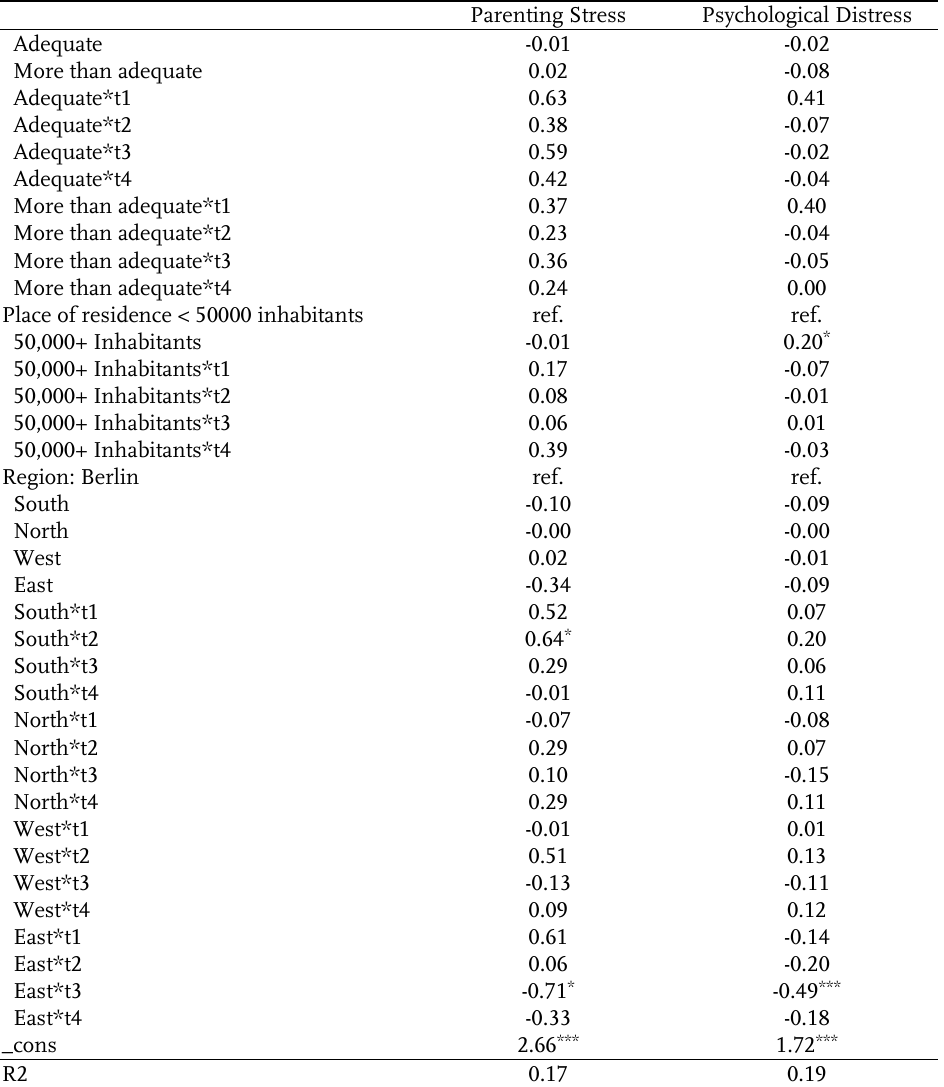
Table A.2: OLS Regressions on Parenting Stress and Psychological Distress (continued) Parenting Stress Psychological